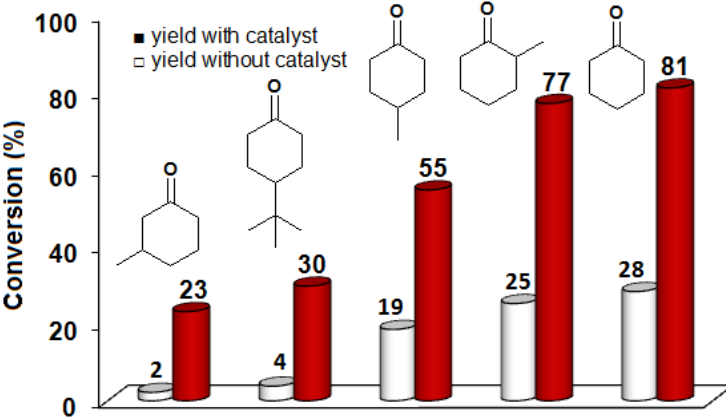
Figure 3. Yields without and with a catalyst for the 2 -catalyzed Baeyer–Villiger oxidation of cyclohexanones. Reaction conditions: [Fe(PBT)(OTf) 2 ] ( 2 ) (0.01 mM), cyclohexanone (10 mM), benzaldehyde (150 mM), CH 3 CN (5 mL), O 2 bubbling, 60 °C, 15 h.